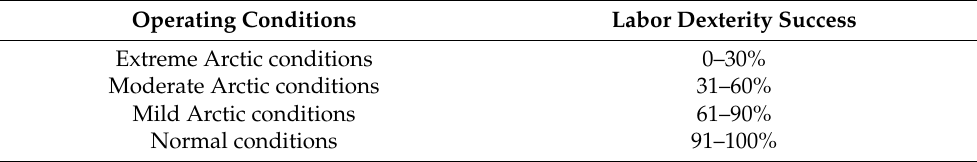
Table 3. Labor dexterity success percentage according to operating